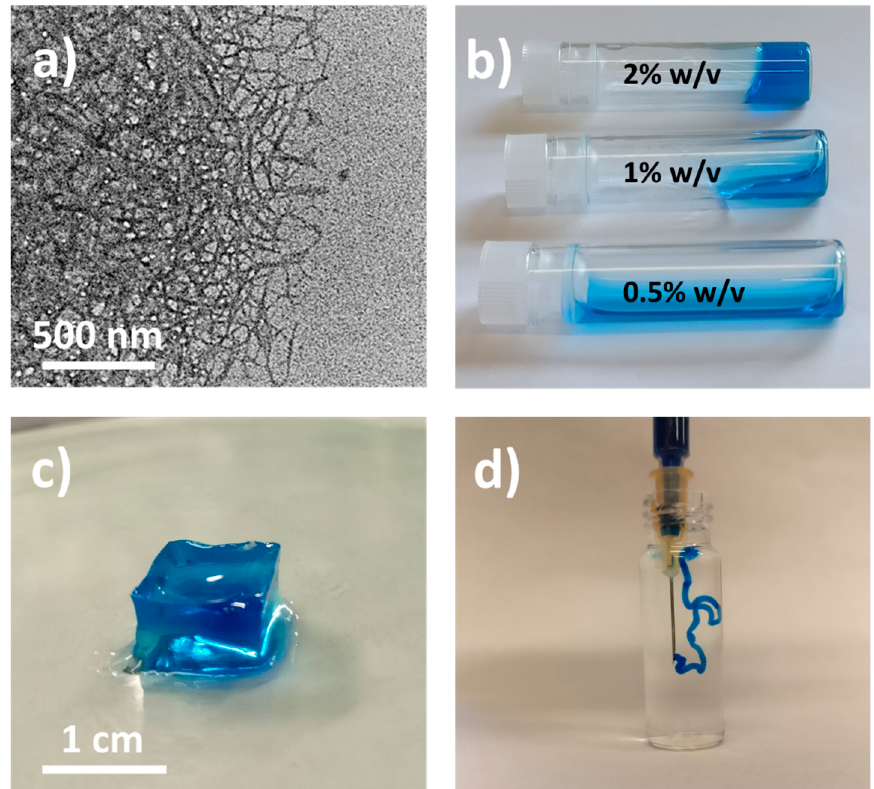
Figure 2. ( a ) Transmission electron microscope (TEM) image of TOUS-CNFs (scale bar: 500 nm); ( b ) Qualitative rheological behaviour of TOUS-CNFs aqueous suspensions at different CNF concentrations (i.e., 0.5, 1 and 2% w / v ); ( c ) example of a cubic-shape TOUS-CNFs/Ca 2+ hydrogel C1 (scale bar: 1 cm); ( d ) extrusion of TOUS-CNFs aqueous dispersion (2% w / v ) into Ca 2+ (100 mM) aqueous solution (indigo dye used to improve the visualization).